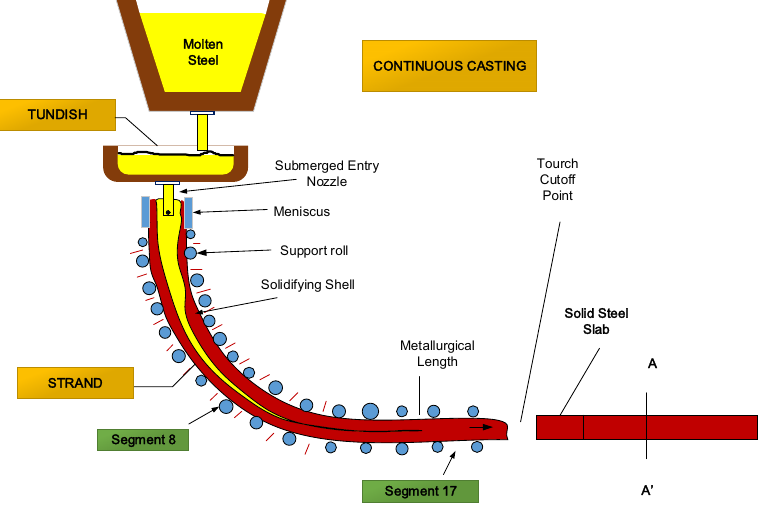
Figure 1. Schematic diagram of the continuous casting of steel